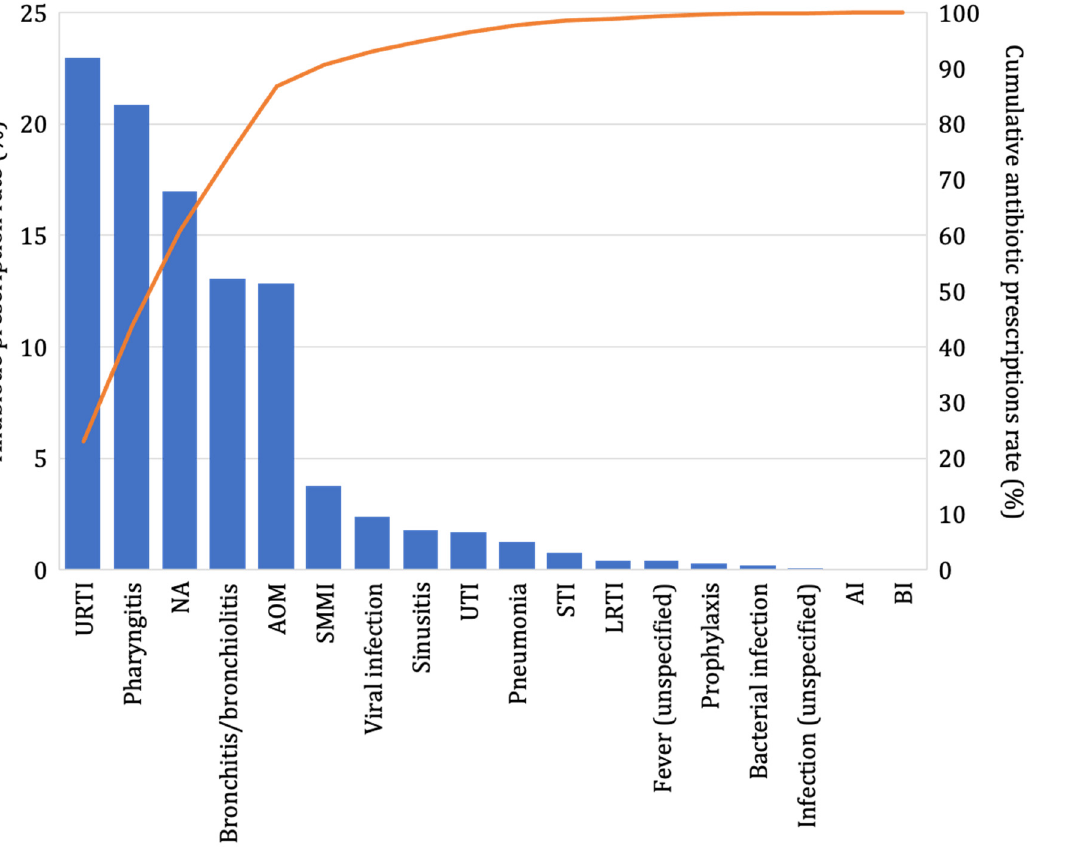
Figure 4. Antibiotic prescriptions’ prevalence rate for all prescriptions, stratified by diagnosis class with the cumulative rate slope shown in orange (Pedianet, 2012–2018). AOM = acute otitis media; URTI = upper respiratory tract infection; LRTI = lower respiratory tract infection; UTI = urinary tract infection; SMMI = skin and mucus membrane infection; STI = soft tissue infection; BI = bone infection; AI = abdominal infection.